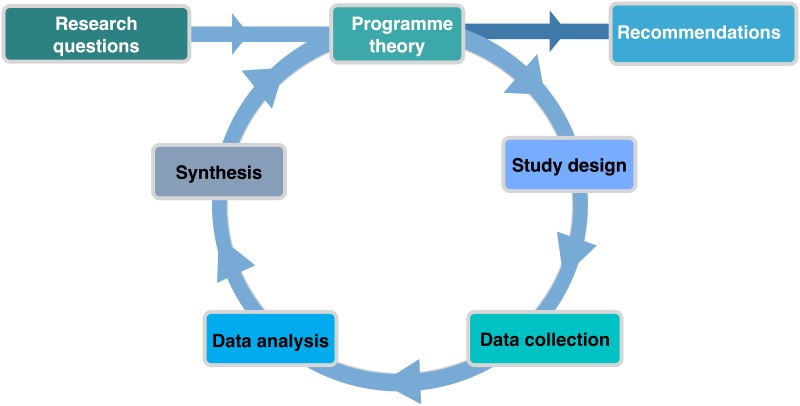
The realist cycle [13].